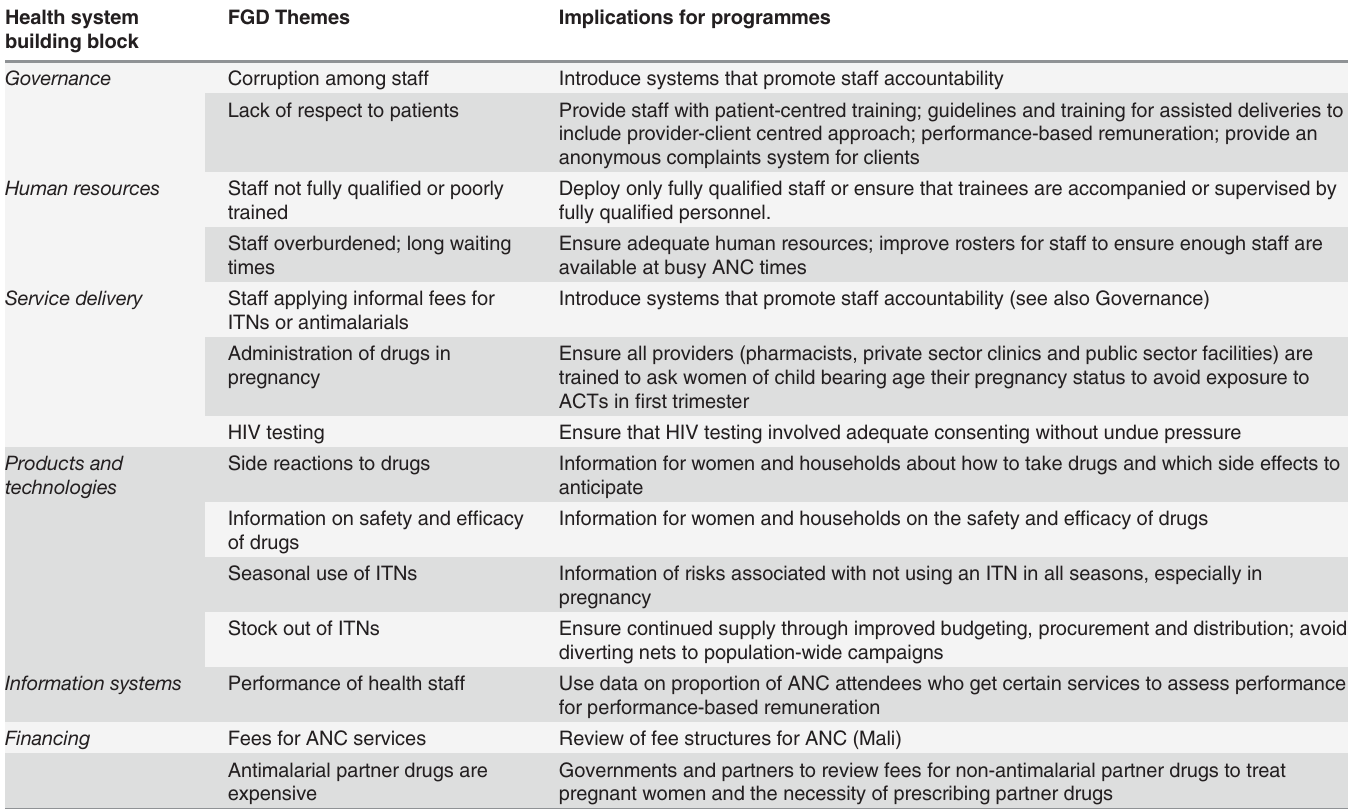
Table 6. Implications of fi ndings for